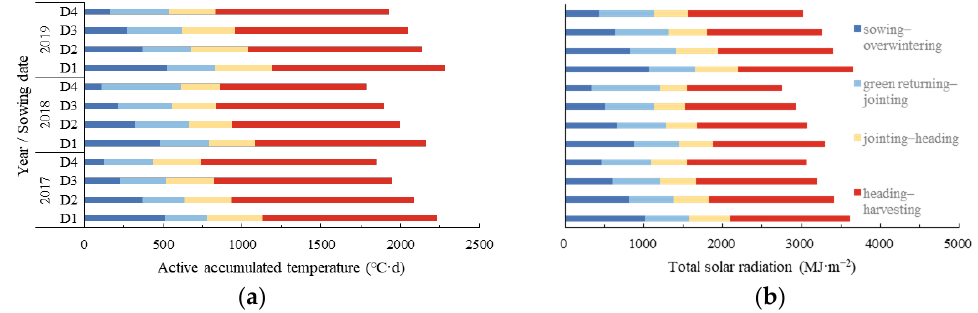
Figure 3. Effects of sowing date changes on the ratio of the vegetative growth period ( a ) and the reproductive growth period ( b ) of winter wheat. Note: D VGP denotes the length of the vegetative growth period, D WGP denotes the length of the whole growth period, D RGP denotes the length of the reproductive growth period. The black dotted lines represent the fitted regression trend line. The asterisks (* or **) indicate the trend’s significance at p < 0.01 (**) and p < 0.05 (*).